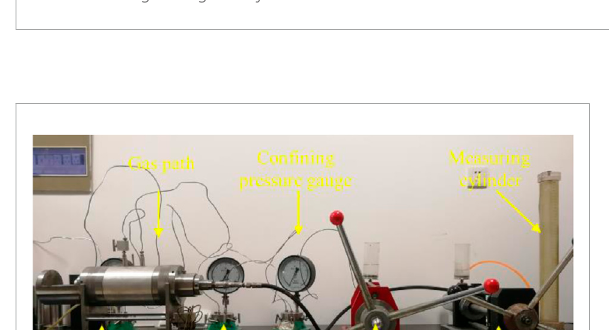
FIGURE 3 Rock strata grouting test system.